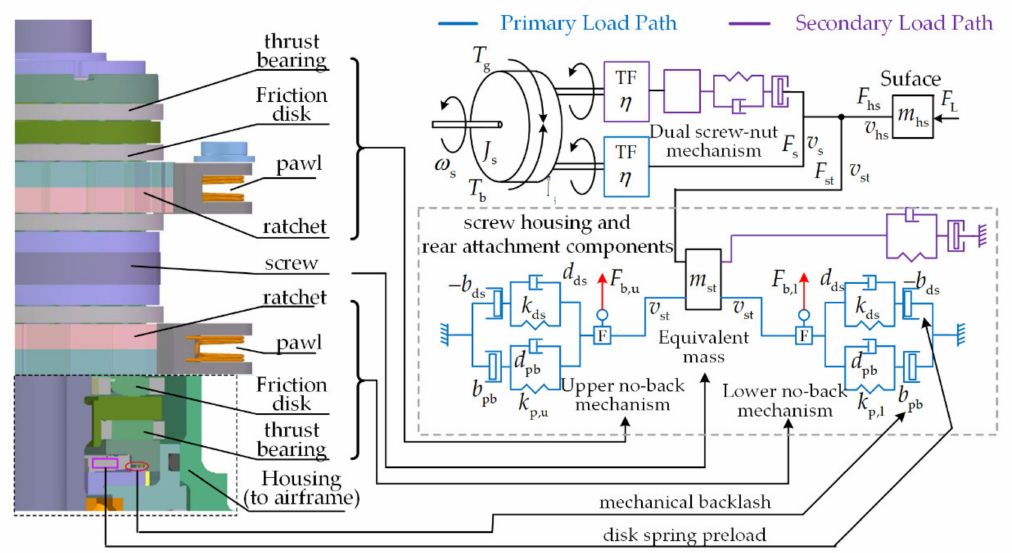
Figure 3. Working principle diagram of mechanical load